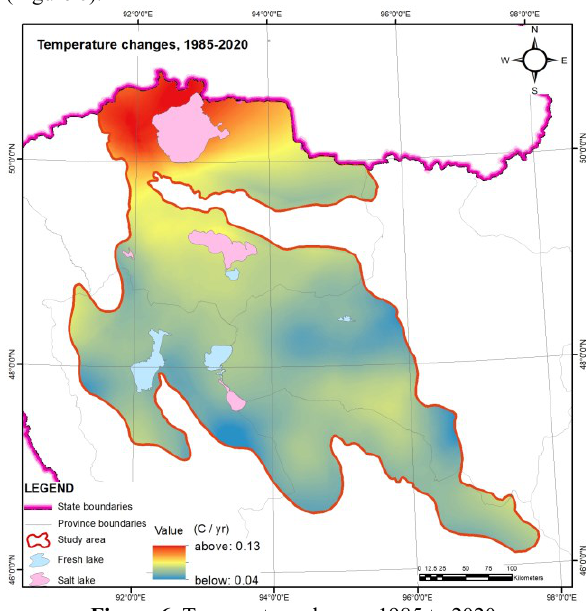
Figure 6. Temperature change, 1985 to